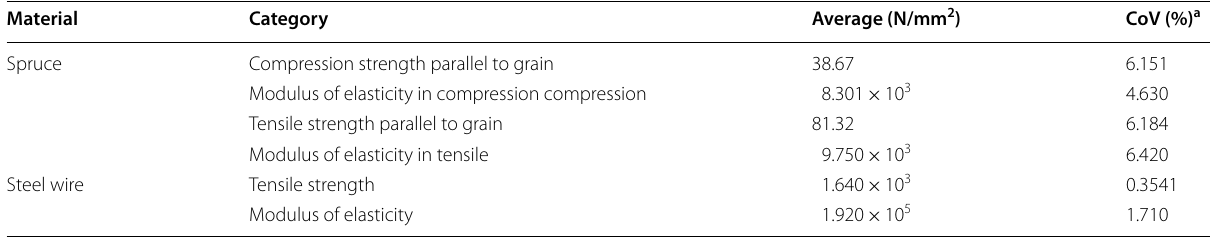
a Coefficient of